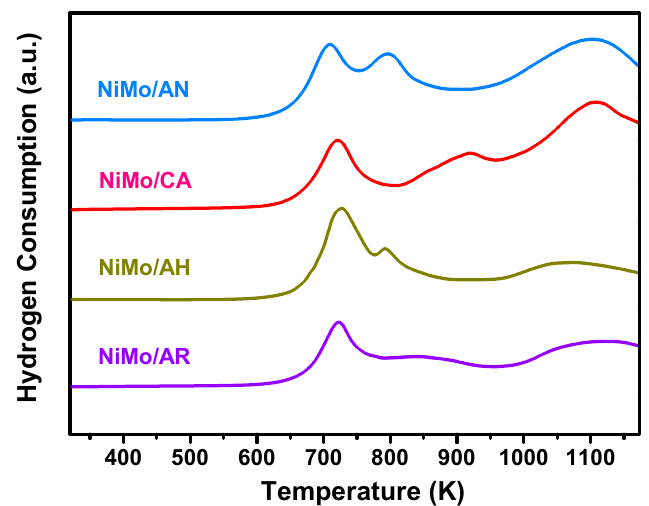
Figure 3. H 2 -temperature-programmed reduction (TPR) profiles of the NiMo/Al 2 O 3 catalysts.